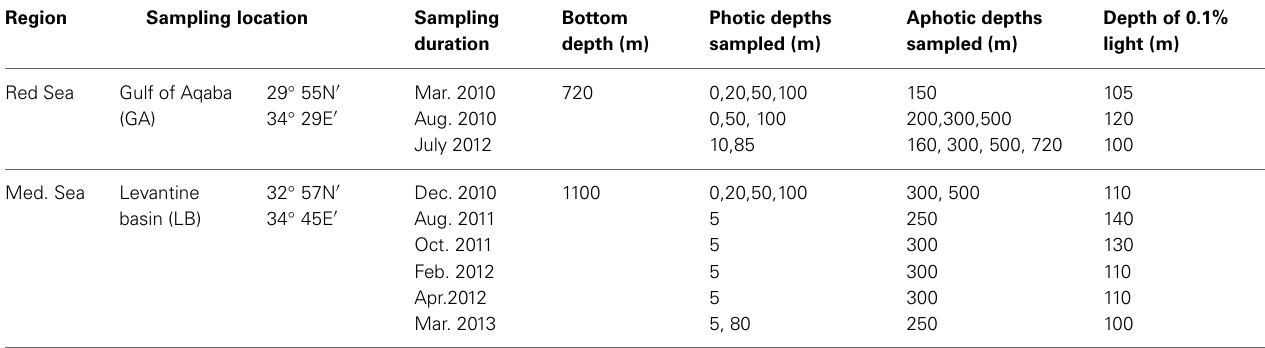
Table 1 | Summary of the sampling dates, locations, and depths.